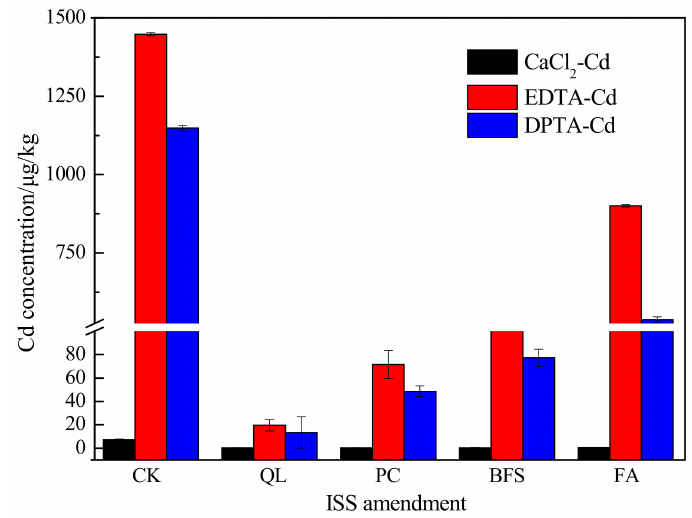
Figure 2. Bioavailable content of Cd in soil contaminated with only Cd. No amendments added (CK), Quick lime (QL), Portland cement (PC), blast-furnace slag (BFS), and fly ash (FA) treatment: CaCl 2 -Cd content <0.5 µ